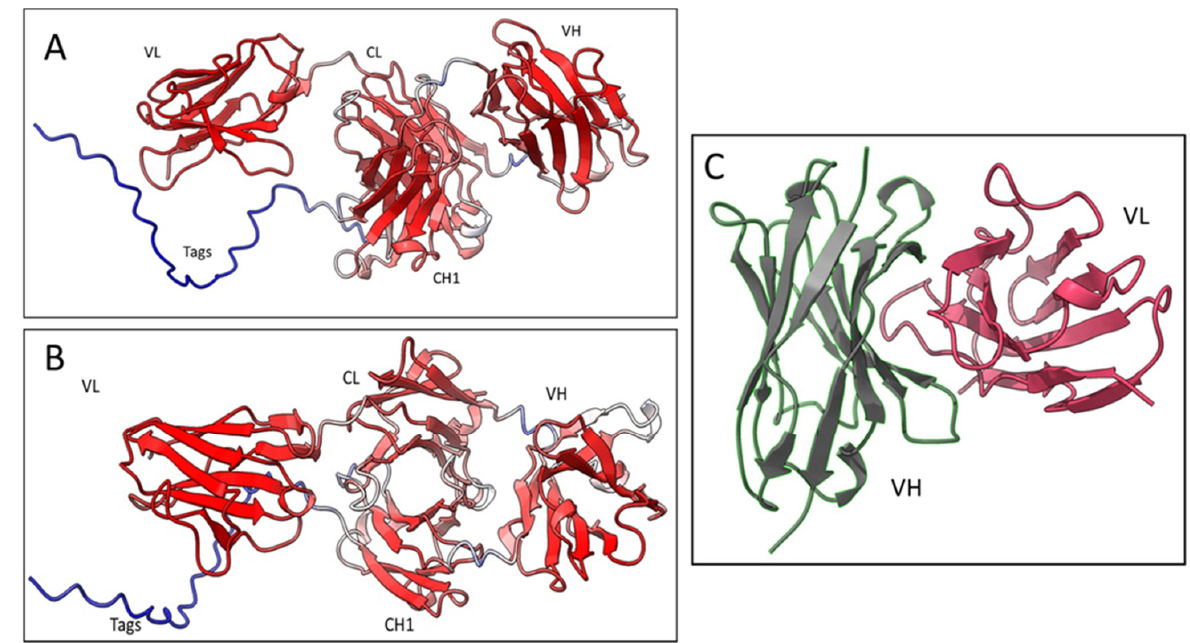
Figure 5. Computational models of the Fab8E-4. ( A ) Predictive model of Fab8E-4 generated with Alpha-Fold2. The pLDDT scores are shown with the following scale of color red > white > blue. ( B ) Same Alpha-Fold2 predicted model rotated for better visualization of the different domains. ( C ) Fv predictive model generated by Antibody-builder (sAbpred server).